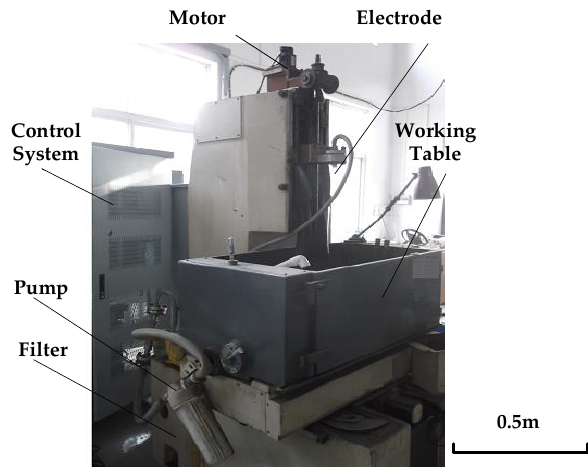
Figure 1. Diagram of ECM equipment processing small hole.